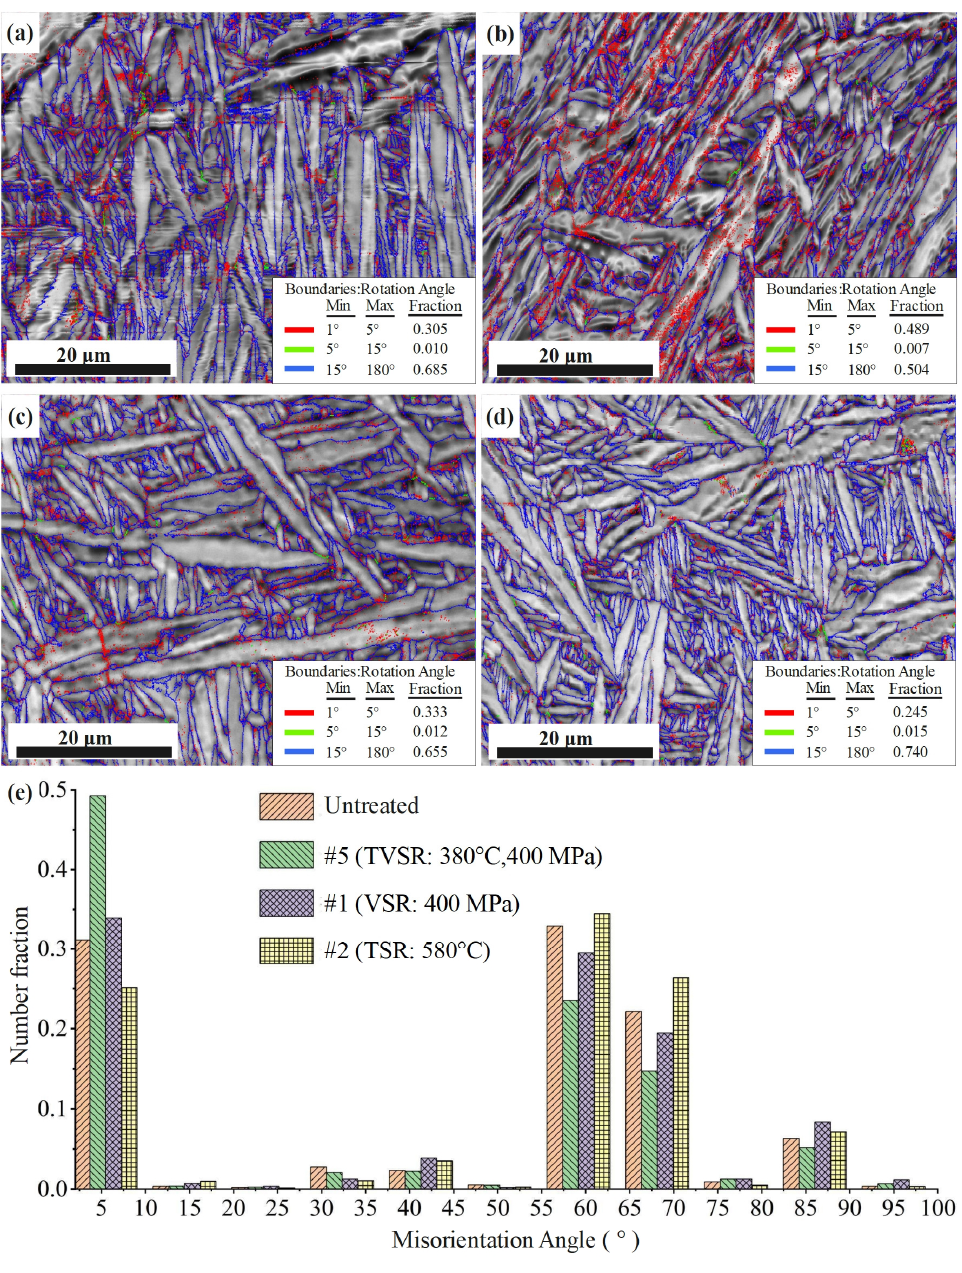
Figure 10. EBSD analysis of rotation angle: ( a ) #0 (untreated); ( b ) #5 (TVSR: 380 °C, 400 MPa); ( c ) #1 (VSR: 400 MPa); ( d ) #2 (TSR: 580 °C); ( e ) misorientation angle.